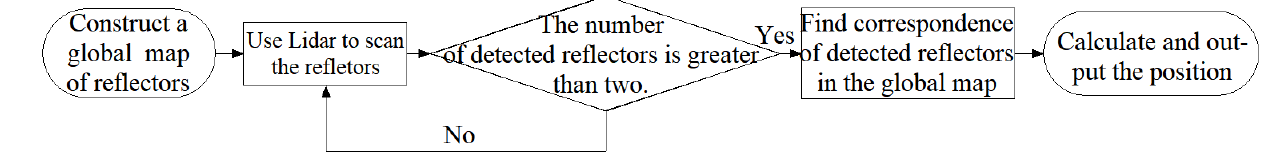
Figure 2. Flow chart of the traditional reflector positioning algorithm.